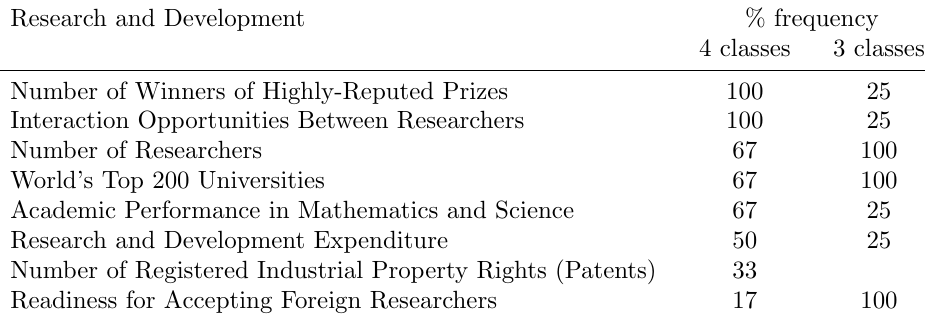
4 classes 3 classes